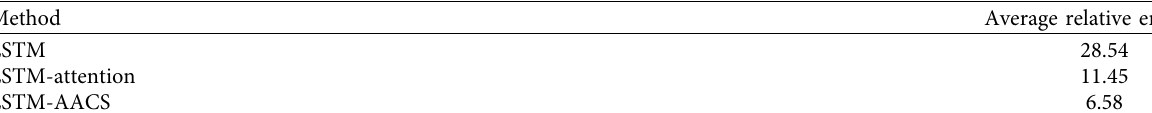
Table 1: Specific error table.